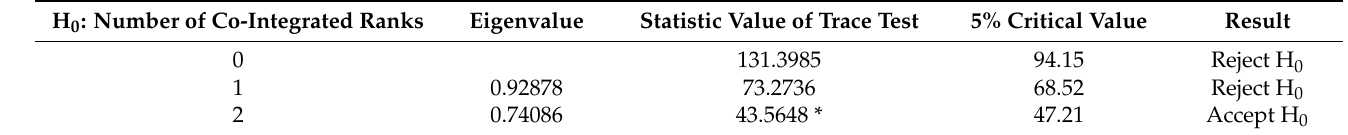
Table 3. Johansen co-integration relationship test of